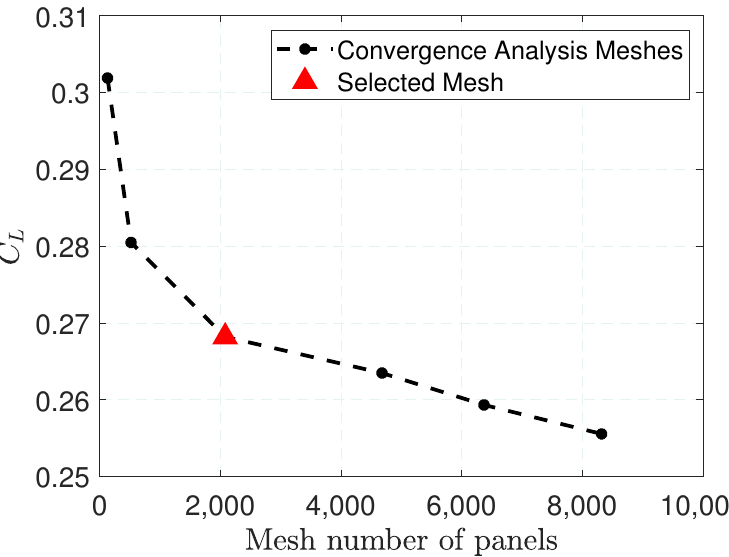
Figure 3. Mesh convergence analysis for steady conditions with α = 20 ◦ and β = 0 ◦